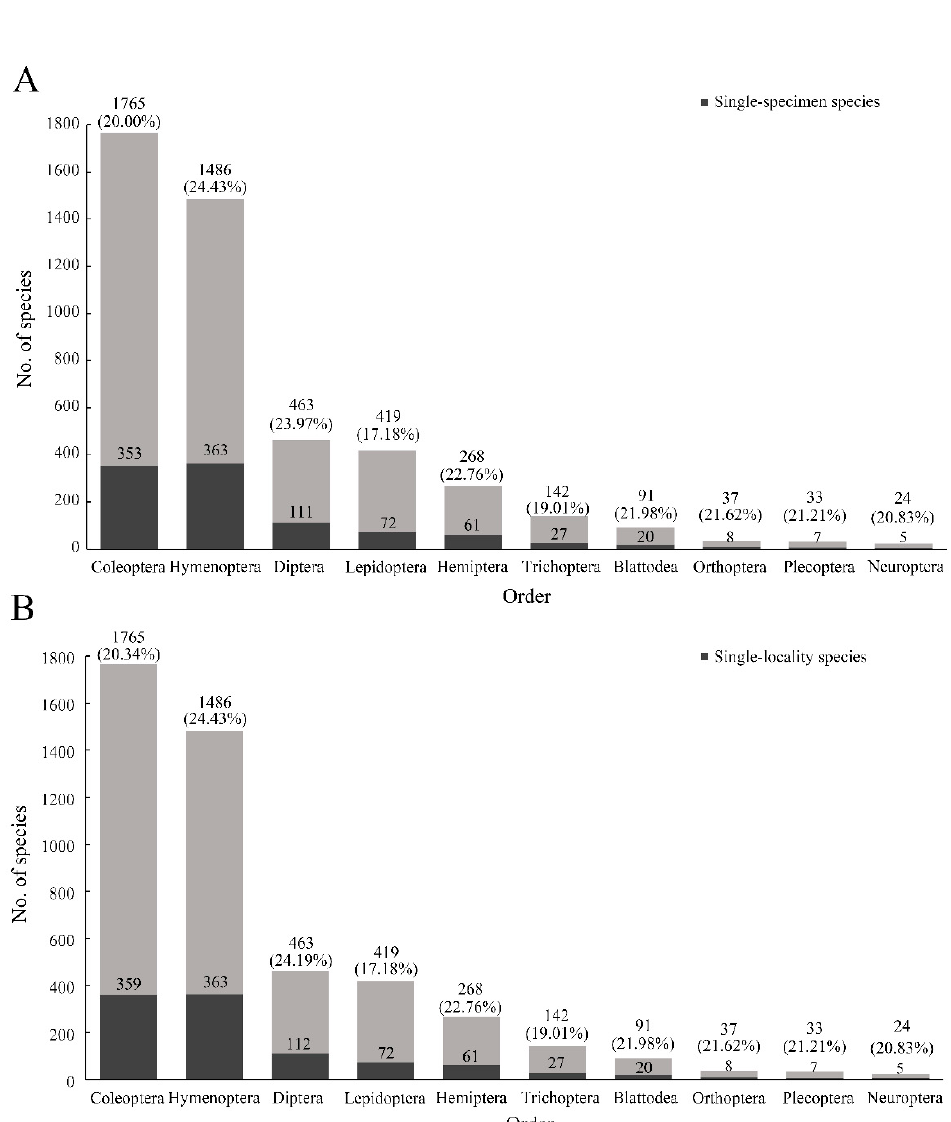
Figure 3. Numbers (dark gray) and relative proportions (percentages in parentheses) of ( A ) single-specimen species and ( B ) single-locality species described by authors from the top 10 insect orders of the most published new species. Values before parentheses indicate total numbers of species described.